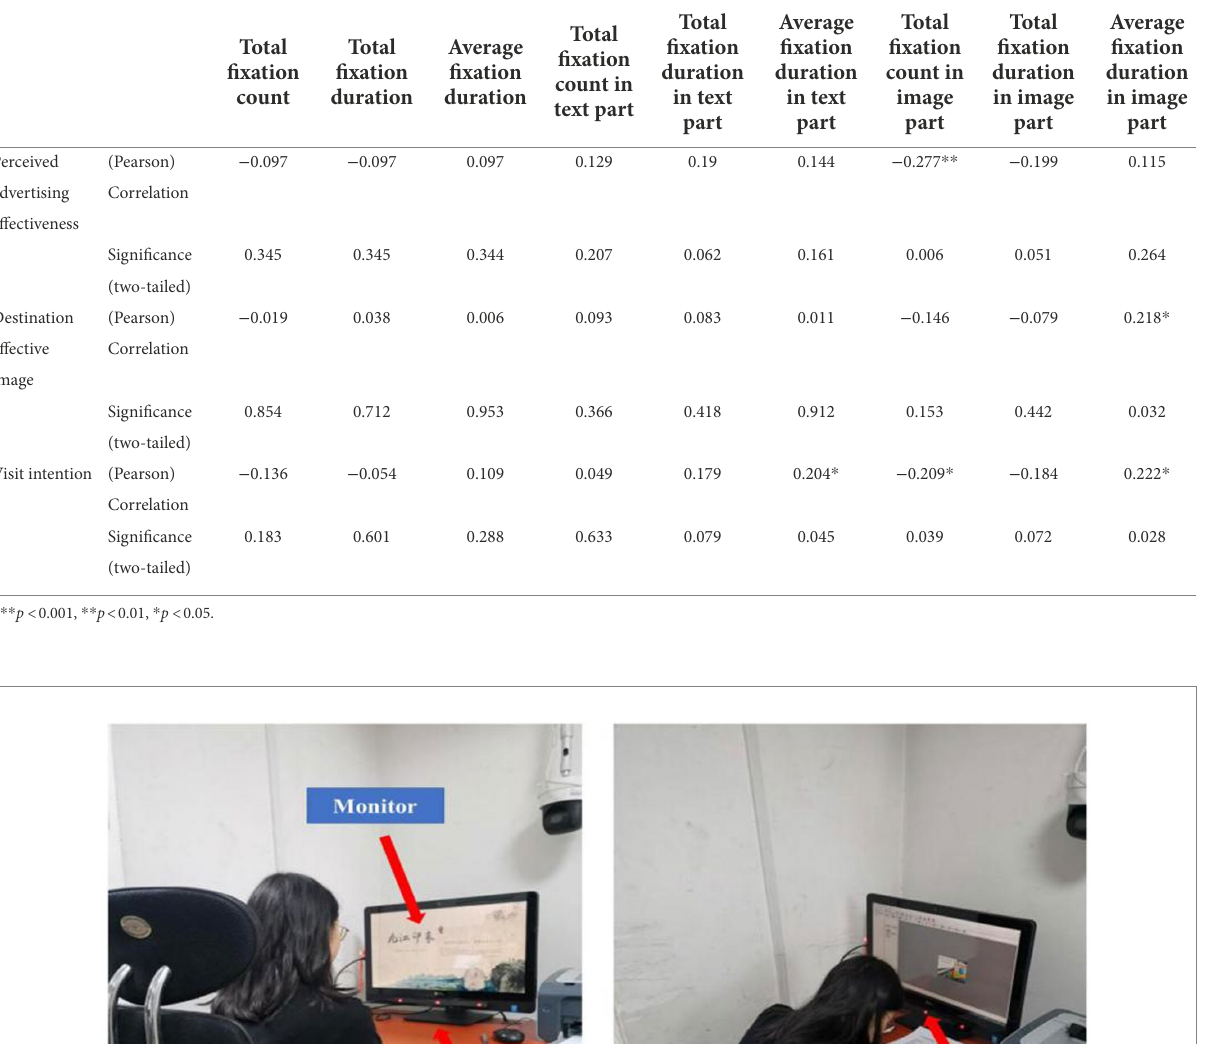
TABLE 7 Correlation analysis result.